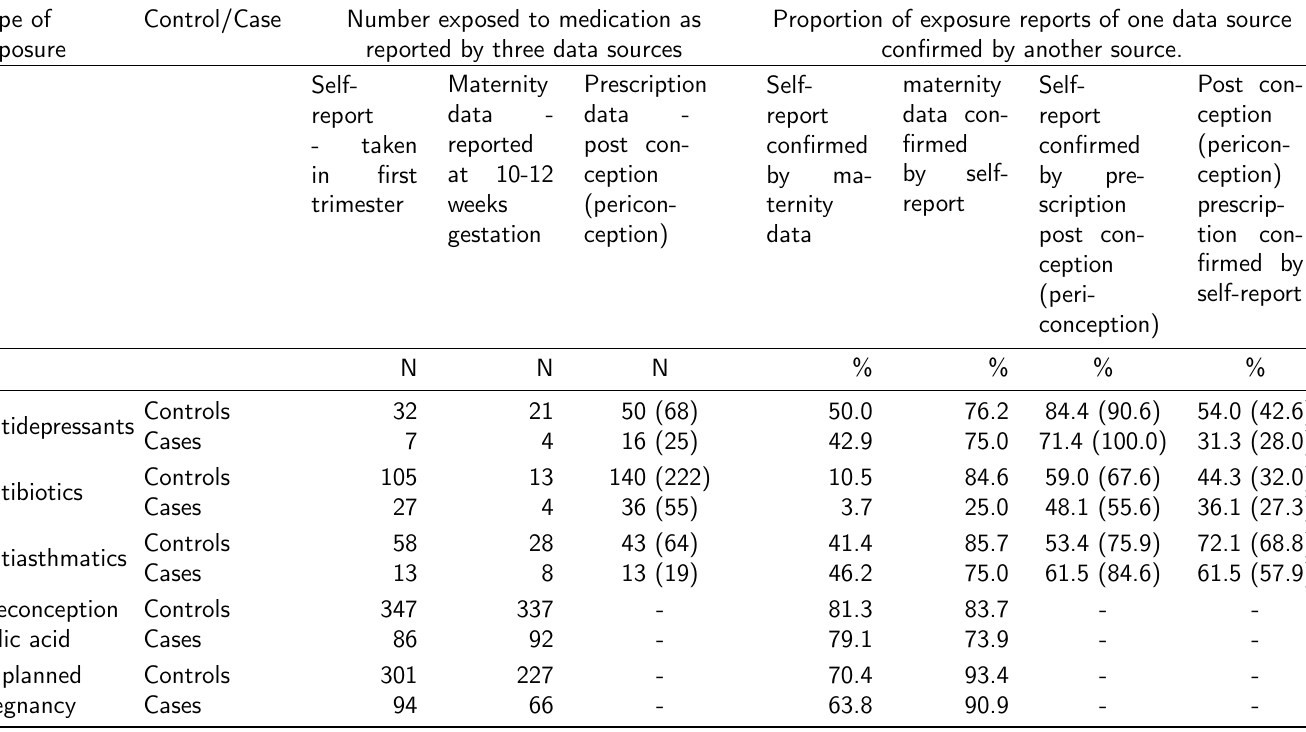
Table 2: Agreement between self-report data (questionnaire) and administrative data (maternity data and prescription records) for medication use, preconception folic acid supplements, and unplanned